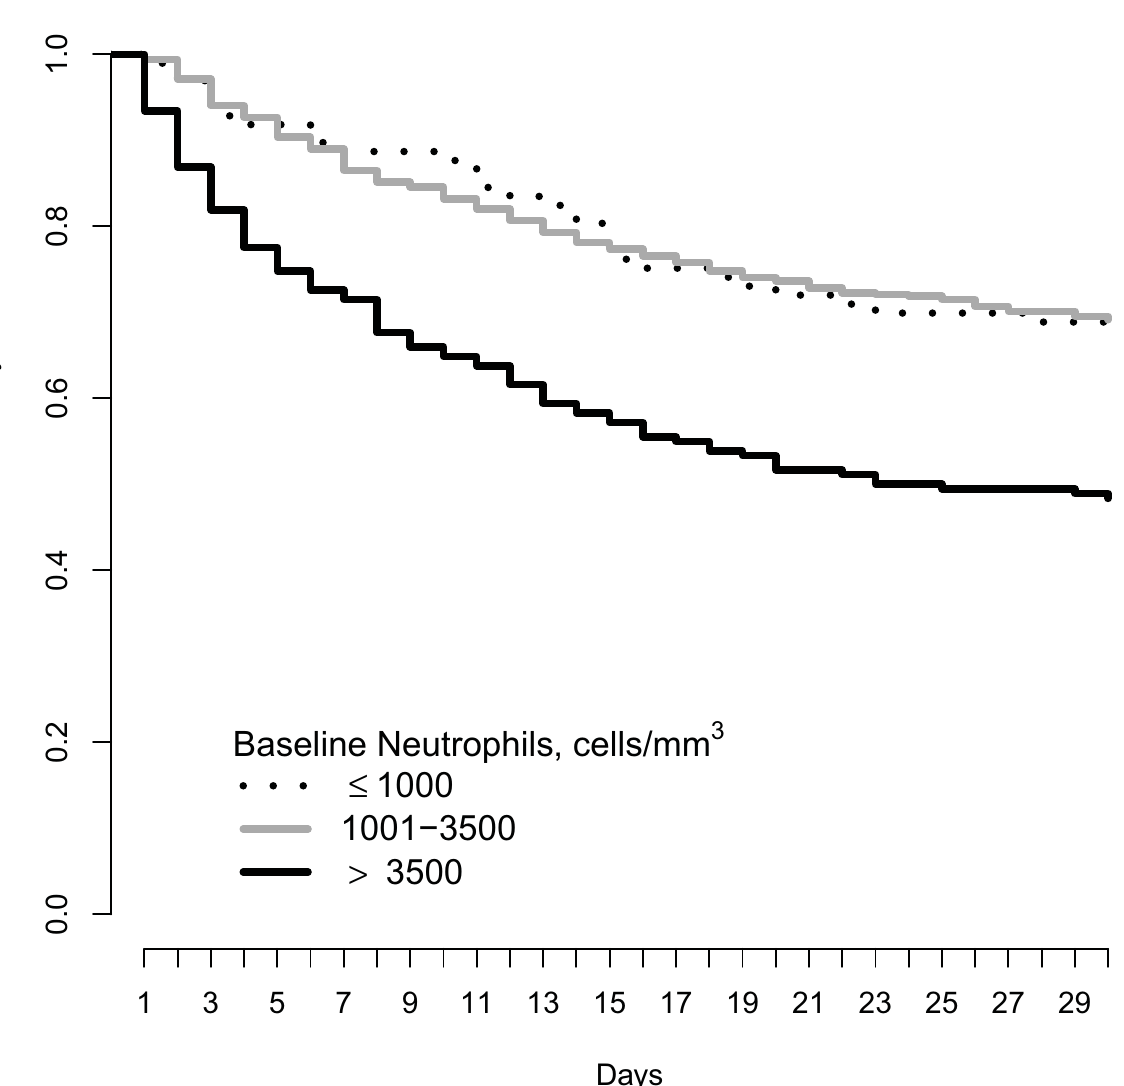
Fig 1. Kaplan-Meier curve describing the survival patients with cryptococcal meningitis by the absolute neutrophil count. The lines represent the absolute neutrophil levels < = 1000 = black dotted, 1001–3500 = grey solid, > 3500 = black solid.